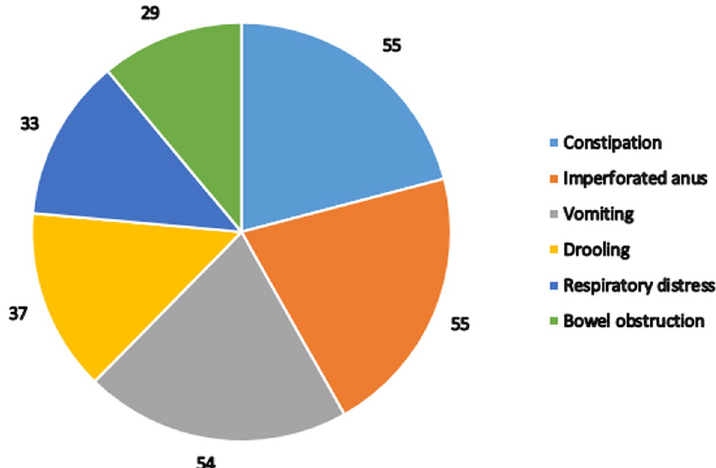
Fig. 2 Representation of symptoms and reasons or